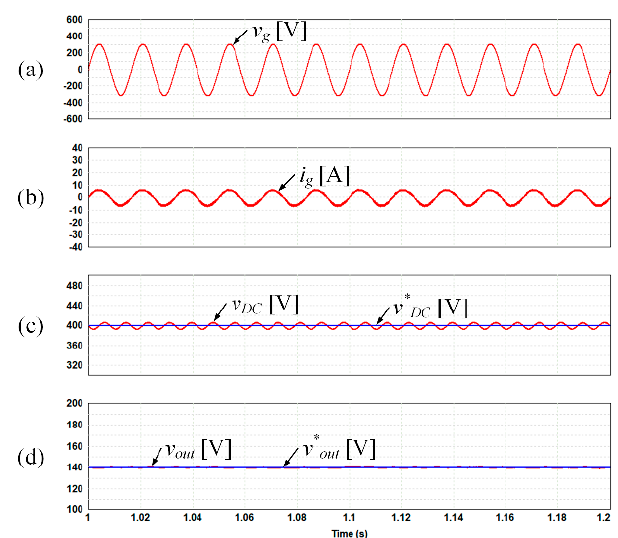
DC and v out , respectively. The v DC is controlled to v *DC , which is set to 400 V, using